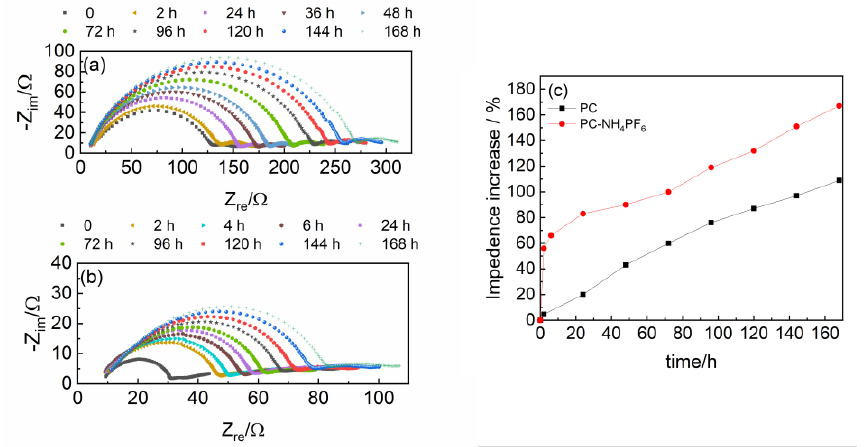
Figure 9. Nyquist plot of cells with ( a ) PC and ( b ) PC-NH 4 PF 6 at different times in rest condition; ( c ) percentage of the interphase impedance increase over time with respect to the impedance at t 0 in PC (black) and in PC-NH 4 PF 6 (red).